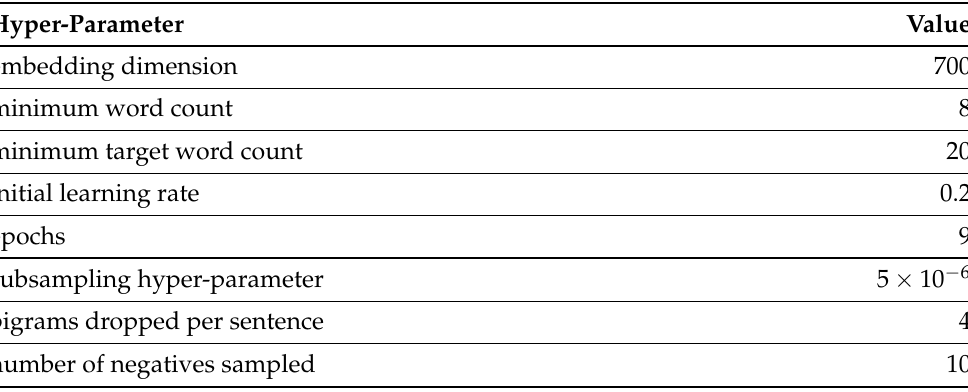
Table A3. Hyper-parameters for training sent2vec